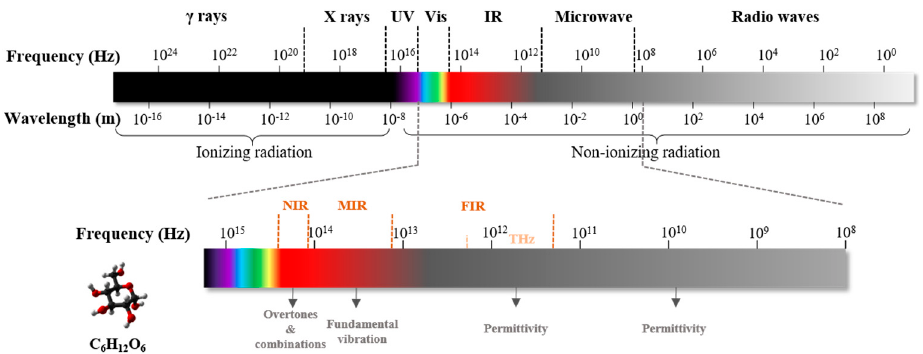
Figure 1. A diagram of the electromagnetic (EM) spectrum and its relevance to glucose. NIR, near-infrared; MIR, mid-infrared; FIR, far-infrared.